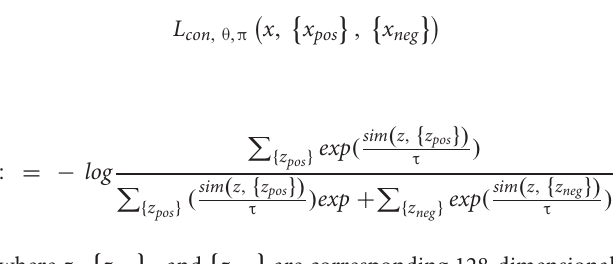
accuracy of the trained encoder and linear layer. Figure 1 shows the architecture described